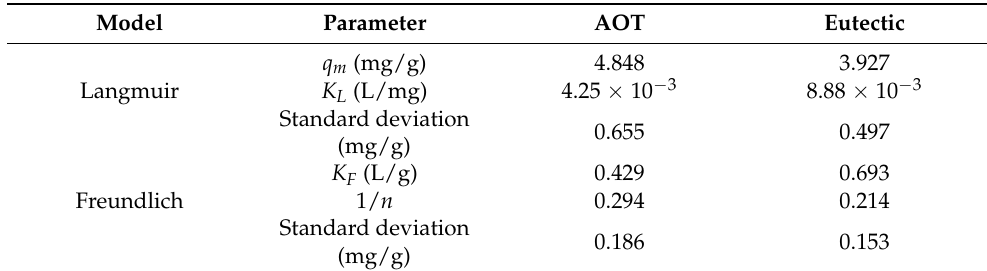
Table 5. Langmuir and Freundlich isotherms parameters obtained from non-linear fit for AOT and for the AOT + PEG-600